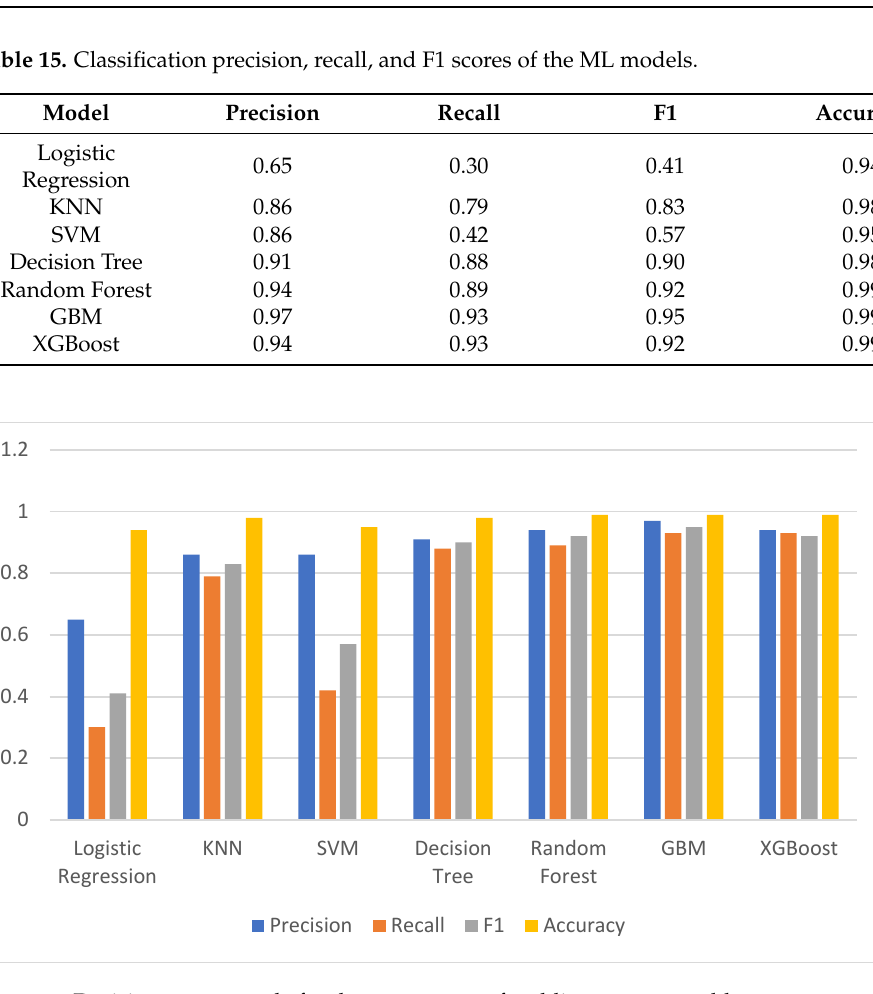
Table 14. Confusion matrix for XG Boost.